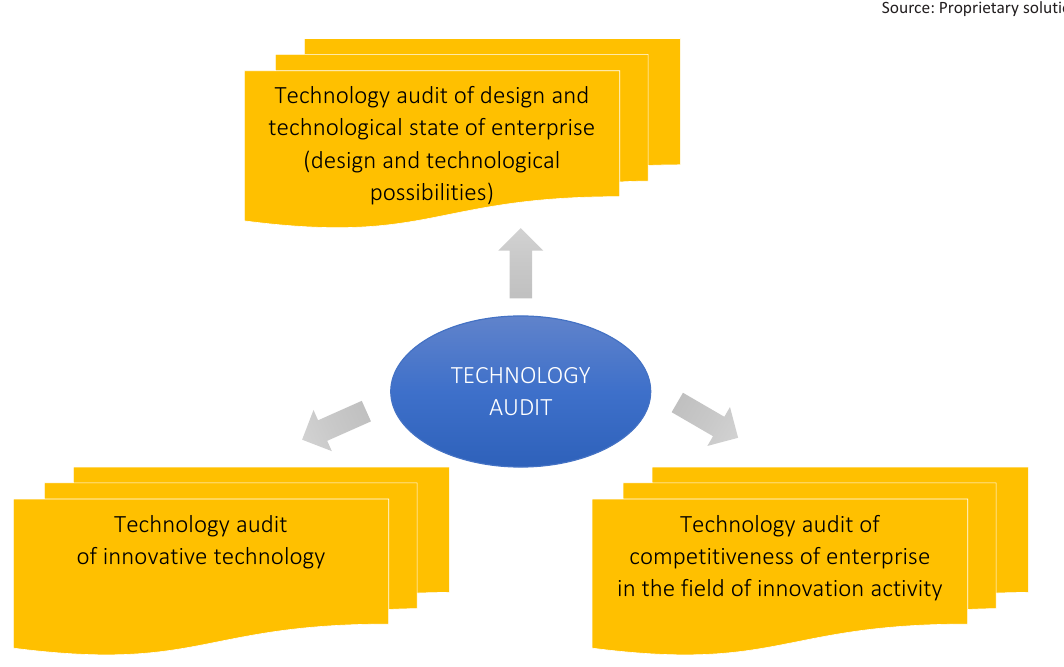
Figure 2. Triad of courses of technology audit at industrial